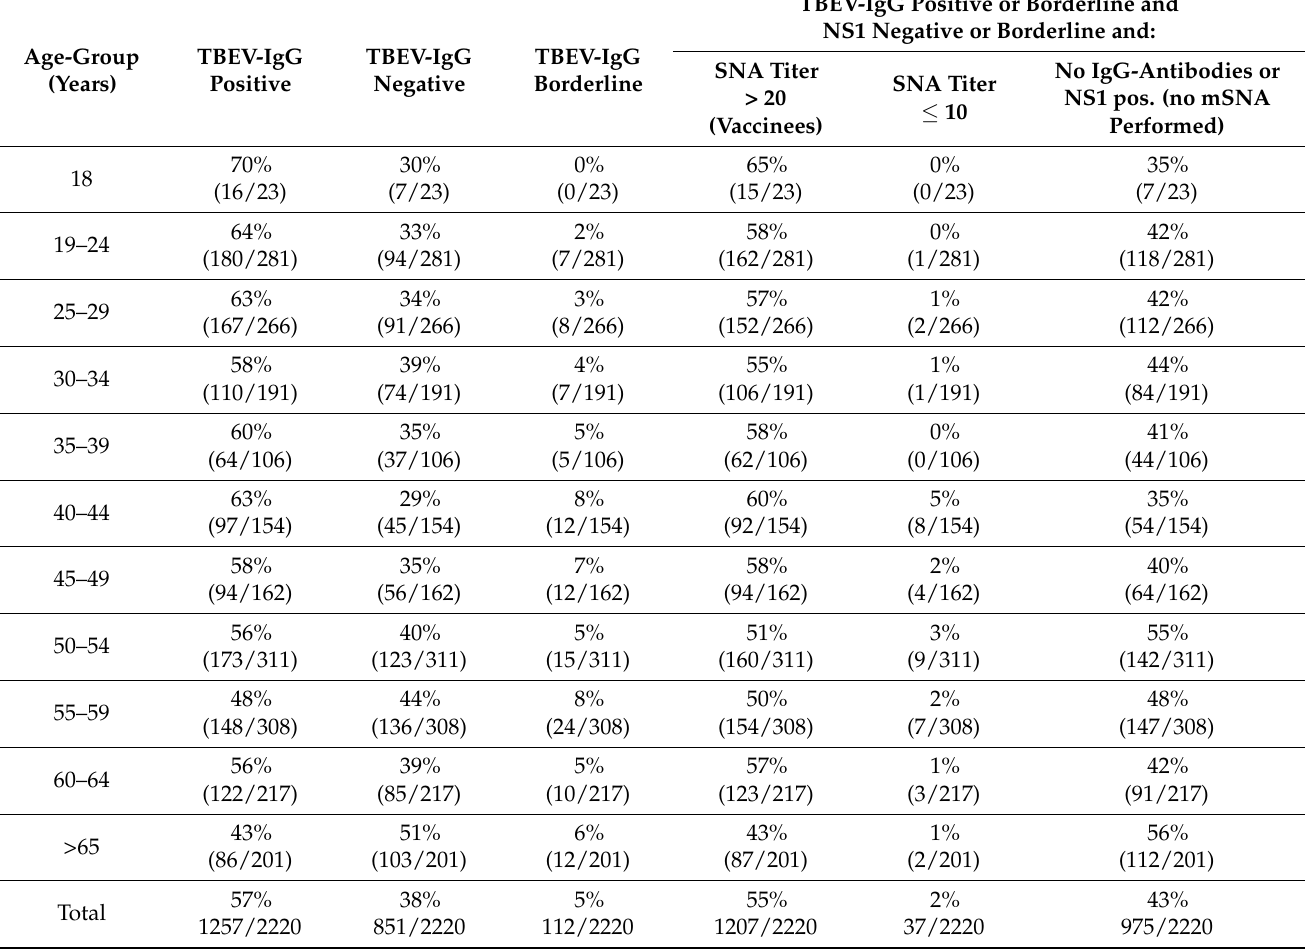
Table 1. Age and sex structure of the vaccinated